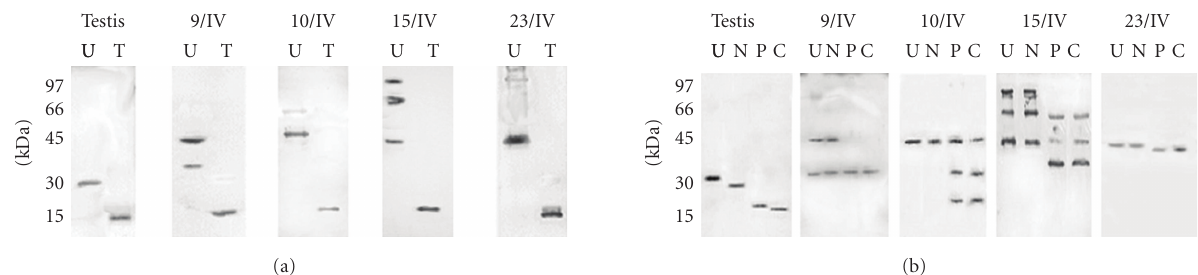
Figure 3: Deglycosylation patterns of healthy human testis and glial tumor Dpl. Testis (microsomal fraction) and astrocytomas (soluble fraction) glycoforms of Dpl were analyzed by chemical deglycosylation with TFMS (a) and by enzymatic deglycosylation with neuraminidase and/or PNGase F (b), followed by immunoblotting using a Dpl-specific polyclonal antibody [10, 11]. U: untreated; T: TFMS treatment;